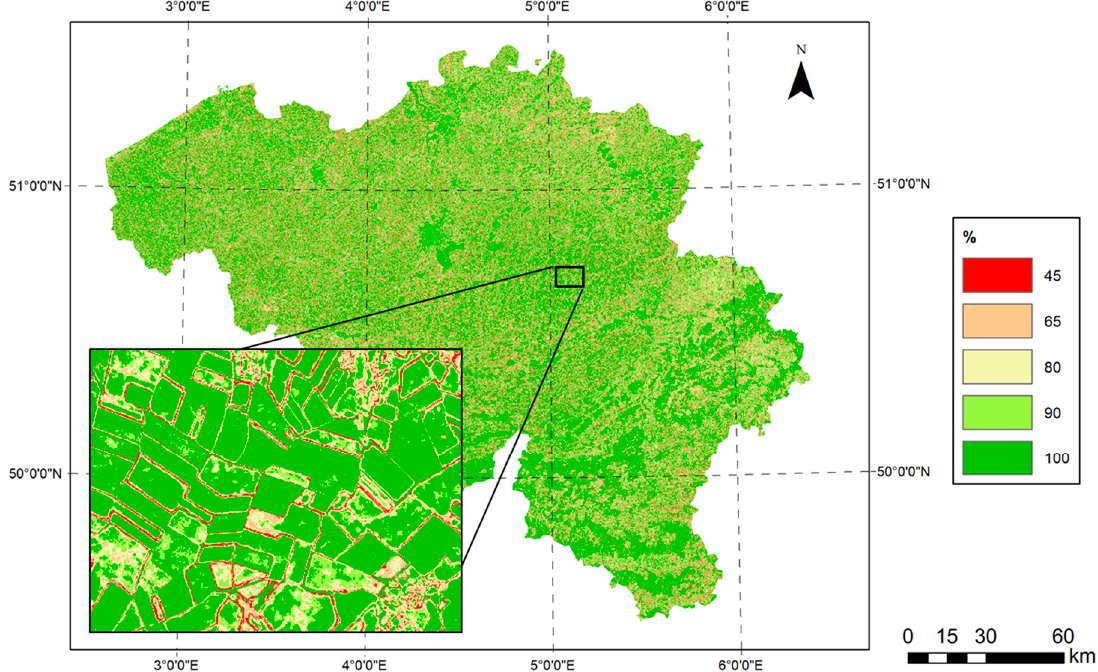
Figure 7. Classification confidence for end of August 2017, defined as the random forest predicted class probability of the majority class for each pixel. Inset shows that the confidence was typically lower at the field borders, which can be explained by spectral contamination of pixels near field edges.